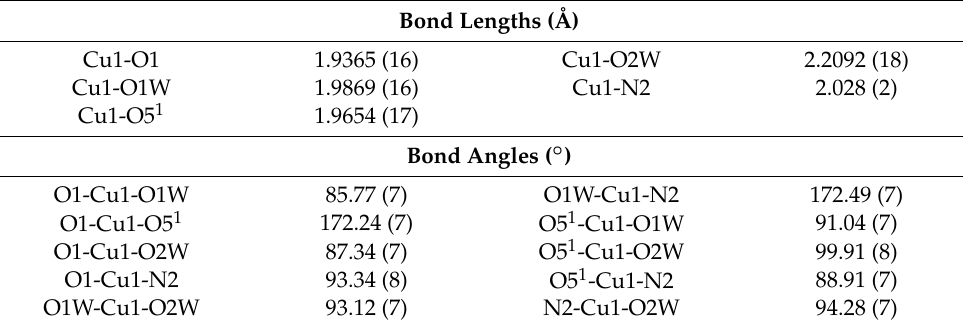
Figure 2. Static water contact angle results for the MOF.